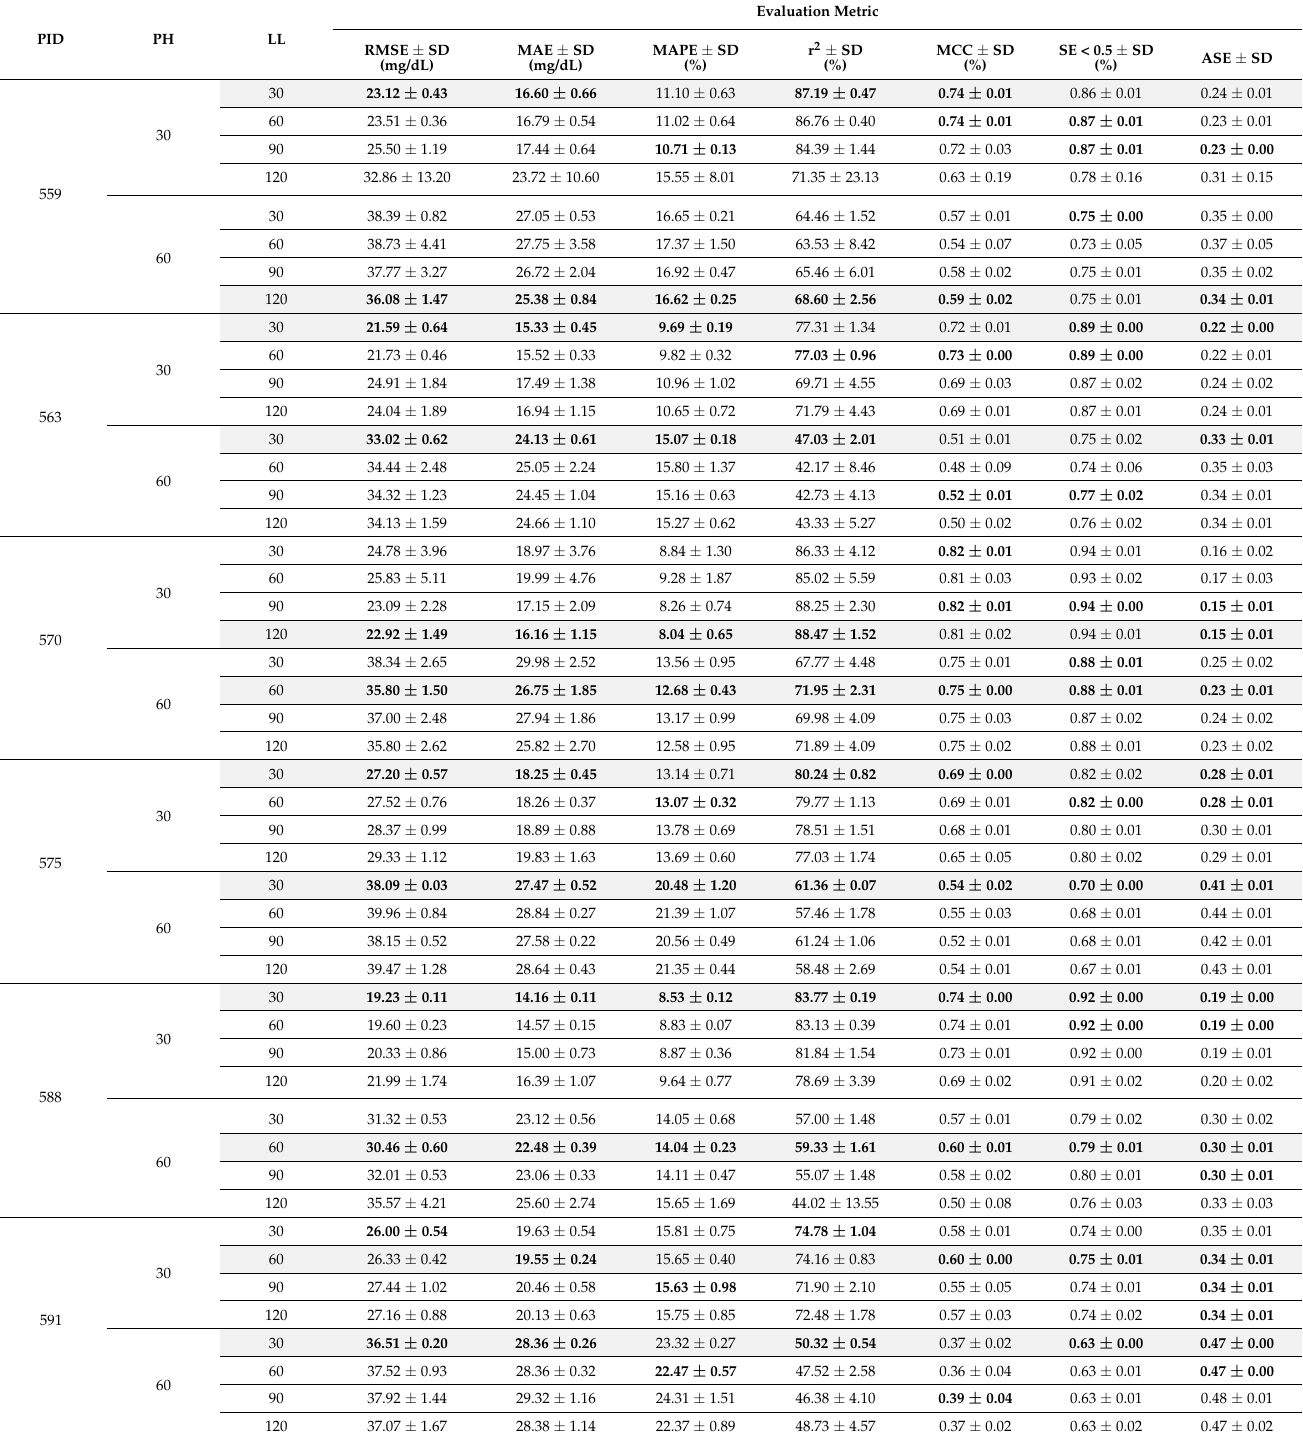
Note. Values in bold indicate the best evaluation outcome for each metric in each learning scenario, and grey highlights denote the best model in each scenario based on the best-achieved evaluation metrics. Note. PID: patient identification; PH: prediction horizon; LL: lag length; RMSE: root mean square error; SD: standard deviation; MAE: mean absolute error; MAPE: mean absolute percentage error; r 2 : coefficient of determination; MCC: Matthew’s correlation coefficient; SE: surveillance error; ASE: average surveillance